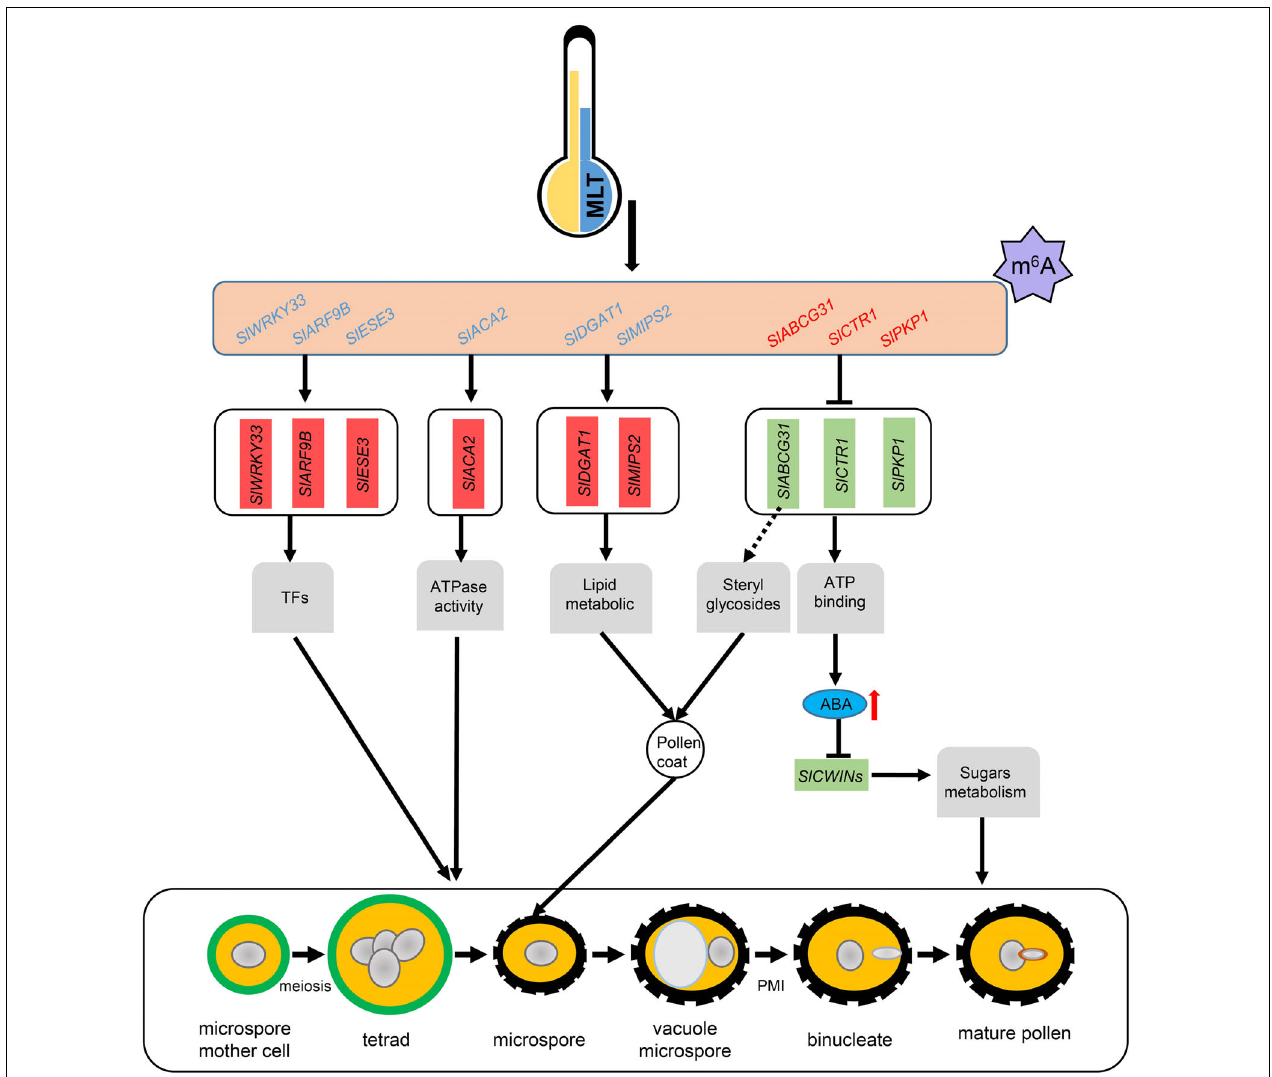
FIGURE 8 | A working model for m 6 A methylation affects pollen development under MLT-stress. MLT, moderate low temperature; TFs, transcript factors; Blue letters means transcripts with lower m 6 A levels, and red letters means transcripts with higher m 6 A levels; Red and green boxes represent unregulated and downregulated genes expression levels, respectively; Red arrow, significant